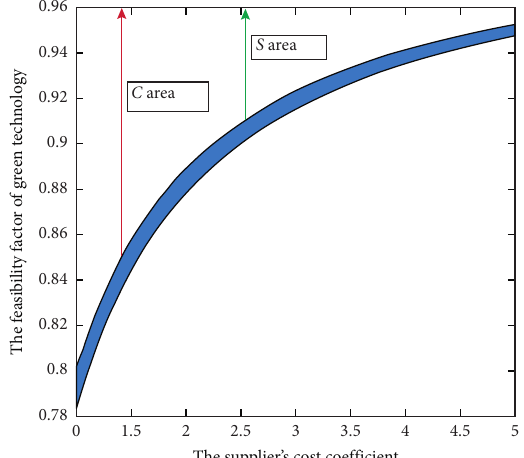
Figure 5: Comparing the choice